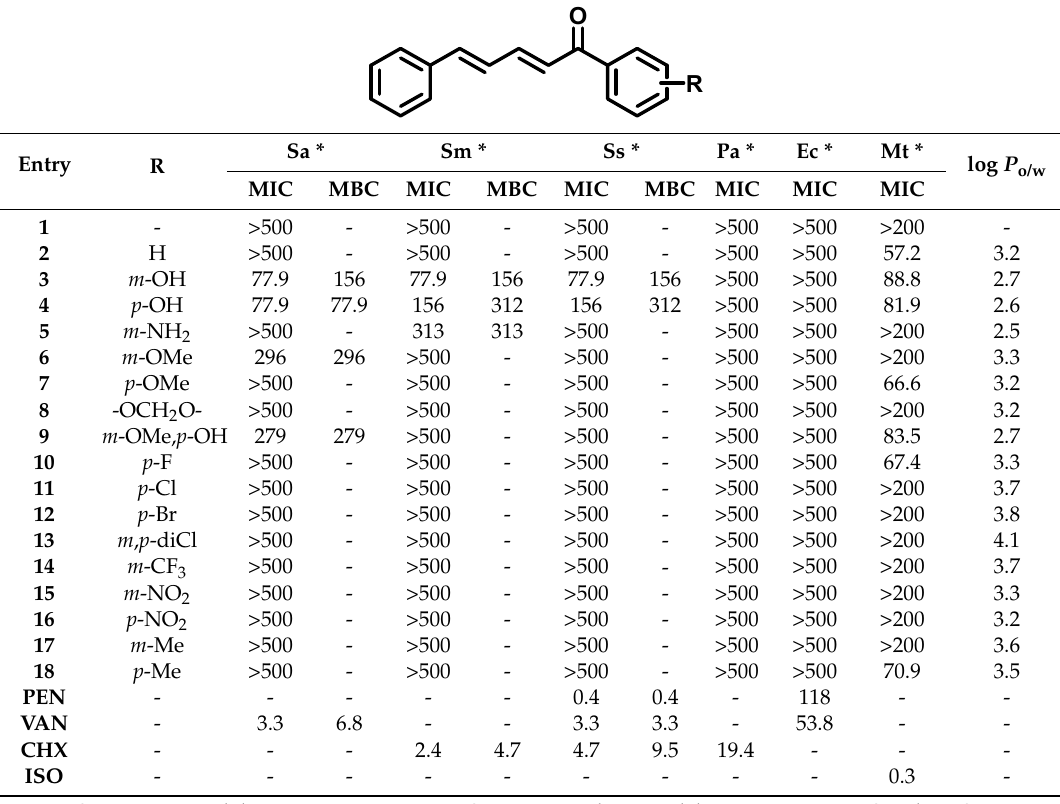
Table 2. Antibacterial and antitubercular activities and log P o/w of cinnamylideneacetophenones.